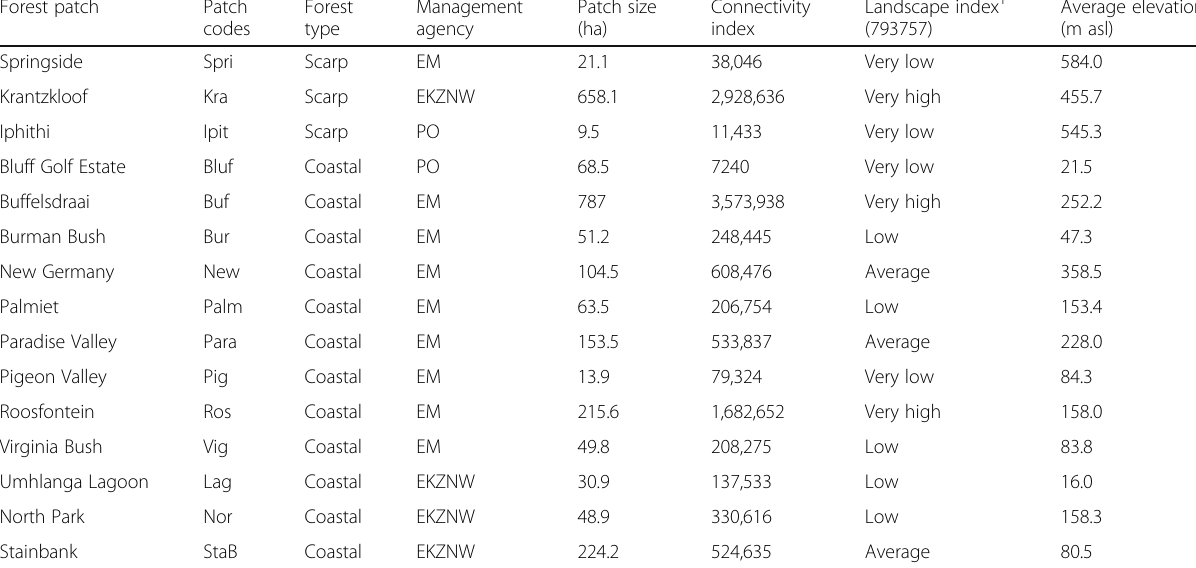
Table 1 Fifteen forest patches of the sampling sites within D ’ MOSS and their details on geographic and management authority of each. EKZNW stands for Ezemvelo KwaZulu-Natal Wildlife, PO for privately owned and EM for eThekwini Municipality Forest